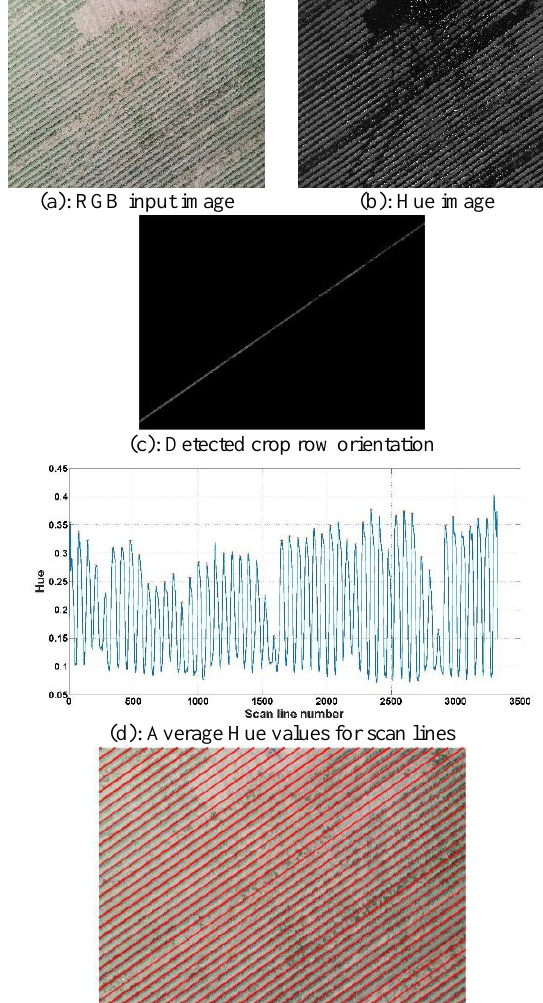
Figure 10. A sample for the achieved results at each step of the